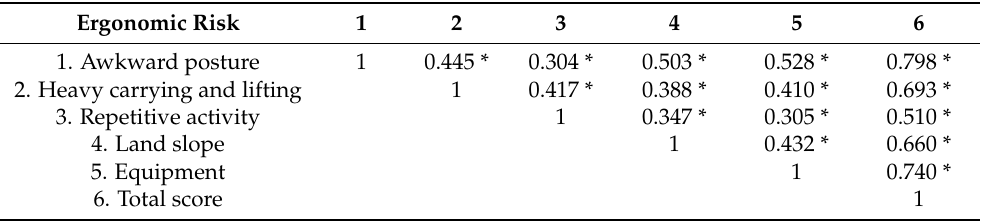
Table 4. Spearman’s rank coefficients (r s ) between ergonomic risk scores classified by domain among ethnic workers.